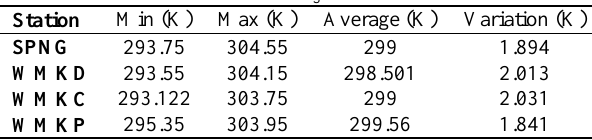
Table 4. The statistical result of T S for each radiosonde station Station